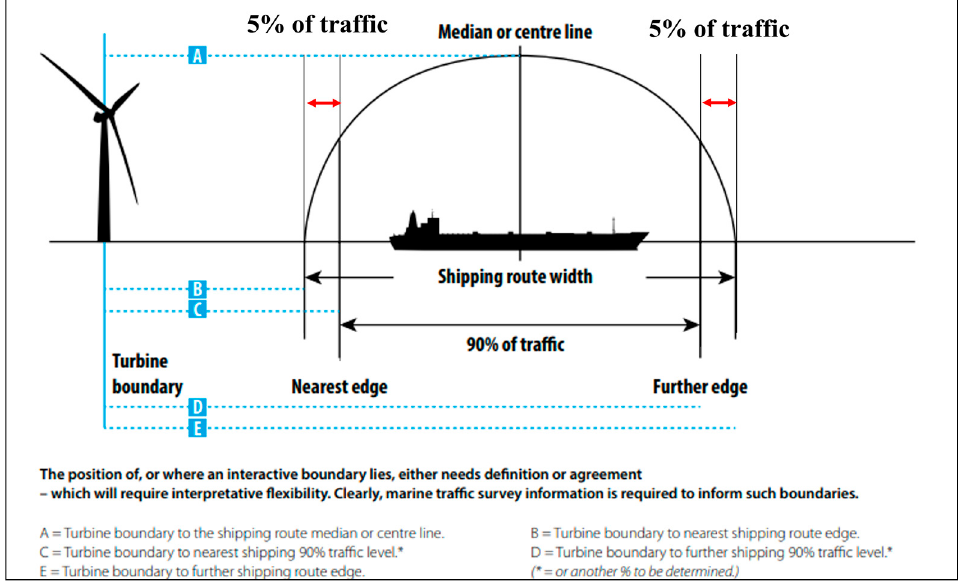
Figure 1. Safety distance between ship traffic and wind turbines recommended by the UK MCA.